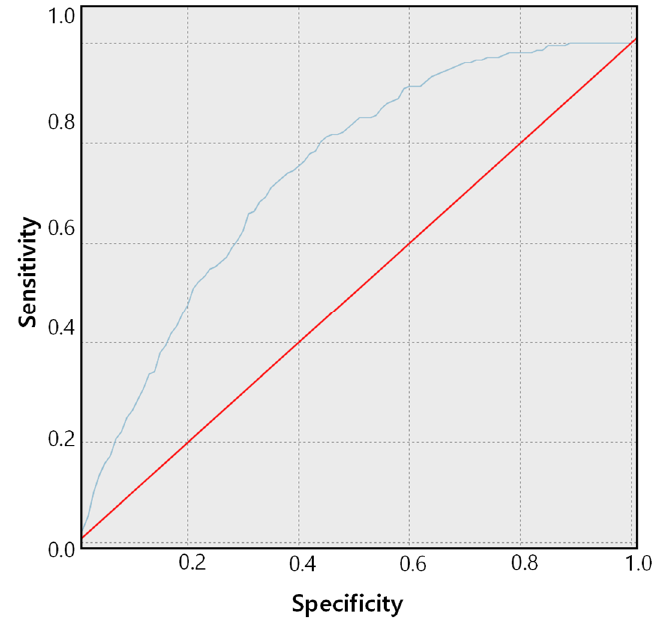
Figure 6. The ROC curve of the CNN-bidirectional LSTM model using raw EEG bio signals. Table 3. DL models’ accuracy, precision, and F1-score based on raw values.